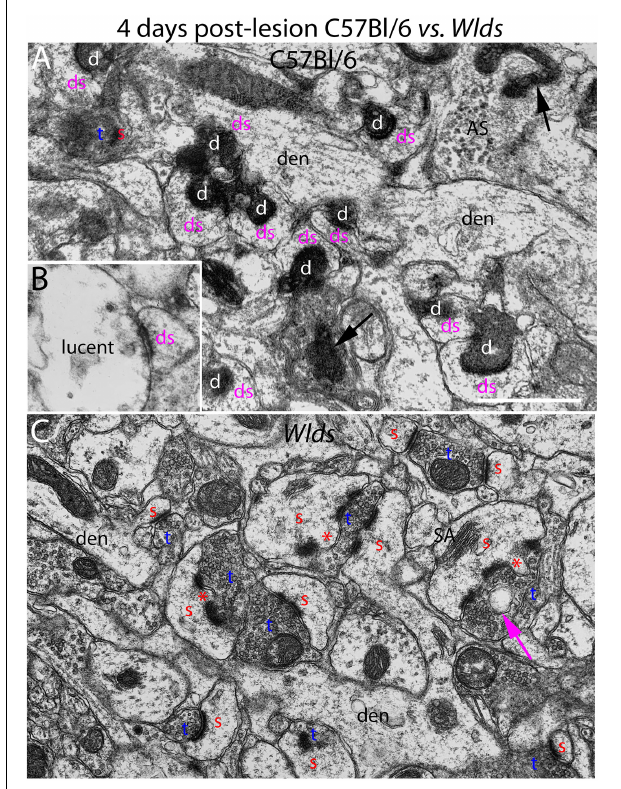
FIGURE 2 | Ultrastructure of synapses at 4 days post-lesion in C57Bl/6 and Wld s mice. (A) Synapses in the middle molecular layer exhibiting typical dark-dense degeneration at 4 days post-lesion in C57Bl/6 mice. Spines contacted by degenerating presynaptic terminals had abnormal morphologies. (B) Presynaptic terminal exhibiting the lucent form of degeneration. (C) Non-degenerating presynaptic terminals in the middle molecular of Wld s mice at 4 days postlesion. Spine heads are large and some have multiple PSDs and some had finger-like protrusions (termed spinules) that extended into the presynaptic terminal (marked by red asterisks). Large complex spine apparatuses (SA) were also evident. Red s, spine head contacted by non-degenerating synapse; Blue t, non-degenerating synaptic terminal; white d, degenerating synaptic terminal; Purple ds, spine contacted by degenerating presynaptic terminal; den, dendrite; ax, myelinated axon. Calibration bar in (A) = 0.25 µ m and applies to (A,B)